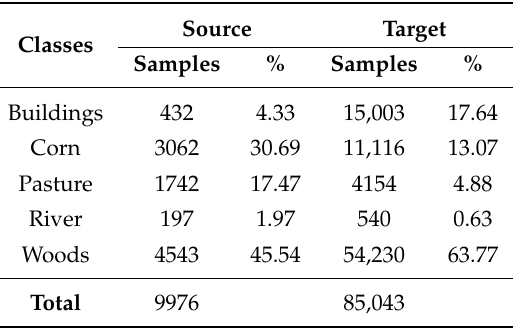
Table 4. Samples available in the Indiana